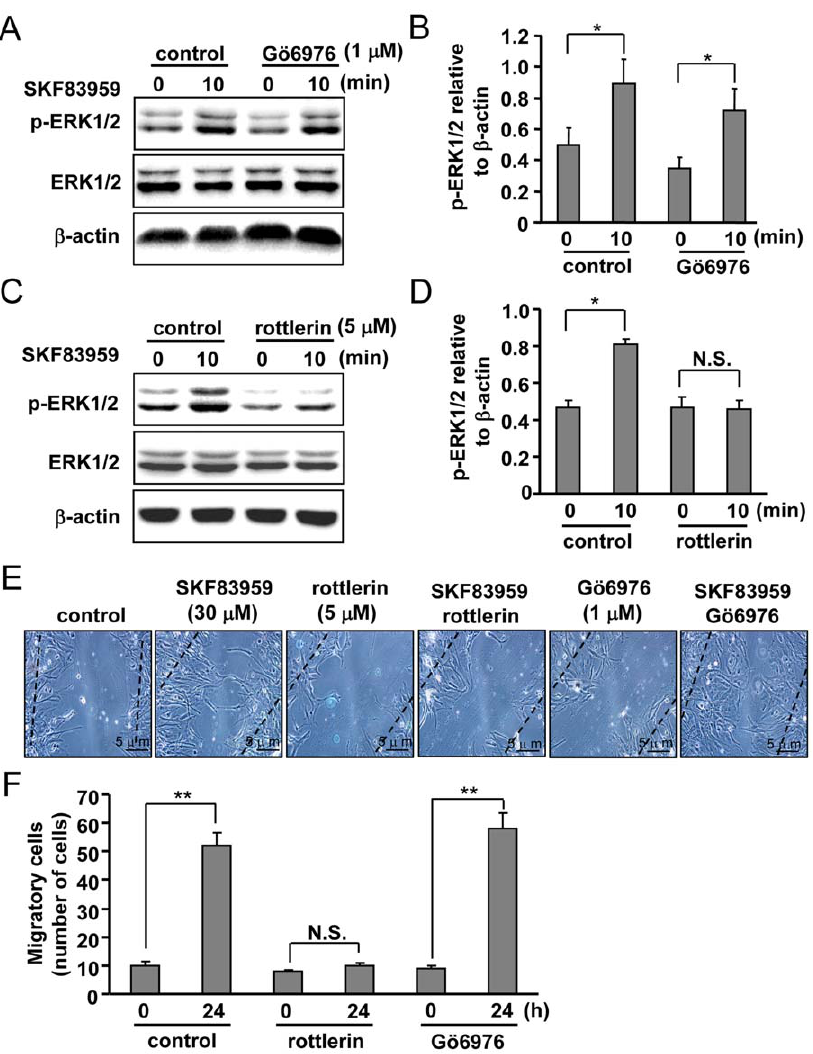
Figure 6. Roles of PKC d and PKC a in SKF83959-induced ERK1/2 phosphorylation. (A) Effects of the PKC a inhibitor Go¨6976 (1 m M, 30 min) on SKF83959 (30 m M, 10 min)-induced ERK1/2 phosphorylation. (B) Quantitative analysis of pretreatment with 1 m M Go¨6976 on SKF83959-induced ERK1/2 phosphorylation (Mean 6 S.E., n=3, * P , 0.05, 10 min vs. 0 min). (C) Effects of PKC d inhibitor rottlerin (5 m M, 30 min) on SKF83959 (30 m M, 10 min)-induced ERK1/2 phosphorylation. (D) Quantitative analysis of pretreatment with rottlerin on SKF83959-induced ERK1/2 phosphorylation (Mean 6 S.E., n=3, * P , 0.05, 10 min vs. 0 min). N.S.: no significance. (E) Respective roles of rottlerin (middle, 5 m M, 30 min) and Go¨6976 (right, 1 m M, 30 min) in SKF83959 (30 m M, 24 h)-induced migration of astrocytes. Bar: 5 m m. (F) Statistical analysis of respective pretreatment with rottlerin (middle) and Go¨6976 (right) on SKF83959-induced migration of astrocytes (Mean 6 S.E., n=3, ** P , 0.01, 24 h vs. 0 h). N.S.: no significance.